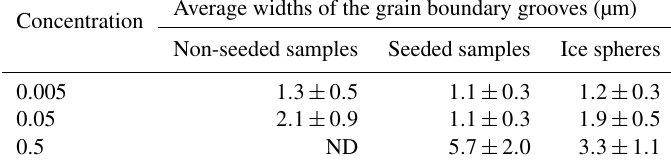
Table 3. The average widths of the CsCl brine-filled grain boundary grooves for the frozen samples prepared from the 0.005, 0.05, and 0.5MCsCl solutions via the three freezing methods. The uncertainties represent the pooled standard deviations. The numbers of independent samples used for the calculation are listed in Table S2. The average width of the grain boundary grooves for the 0.5M non-seeded sample was not determined because the brine layer covered almost the whole surface of this sample. ND stands for not